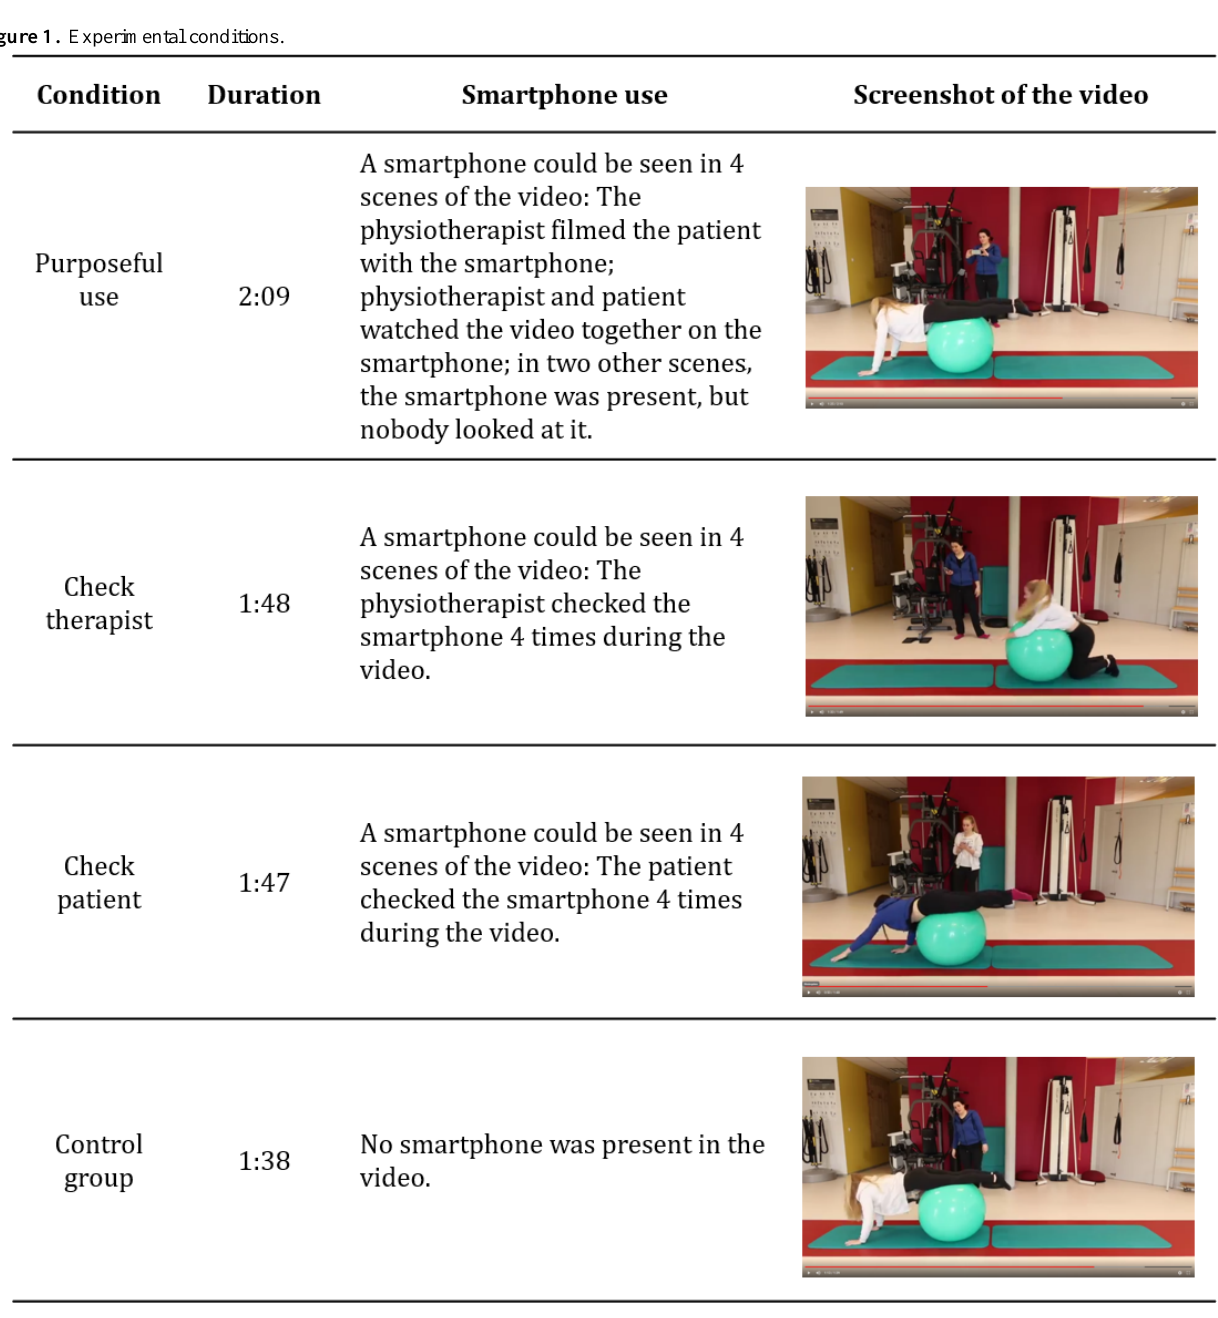
Figure 1. Experimental